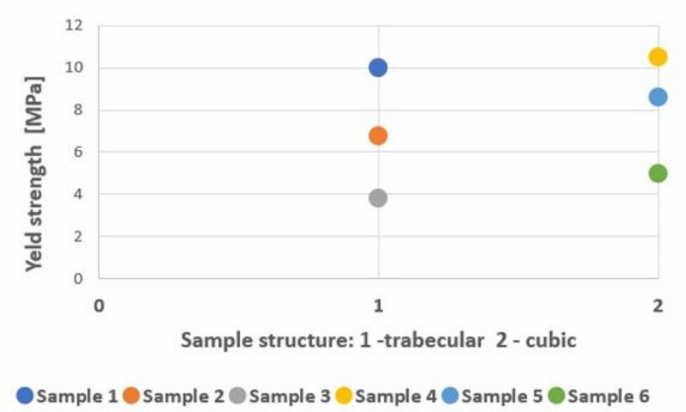
Figure 15. Comparison of yield strength considering the structure of the sample types